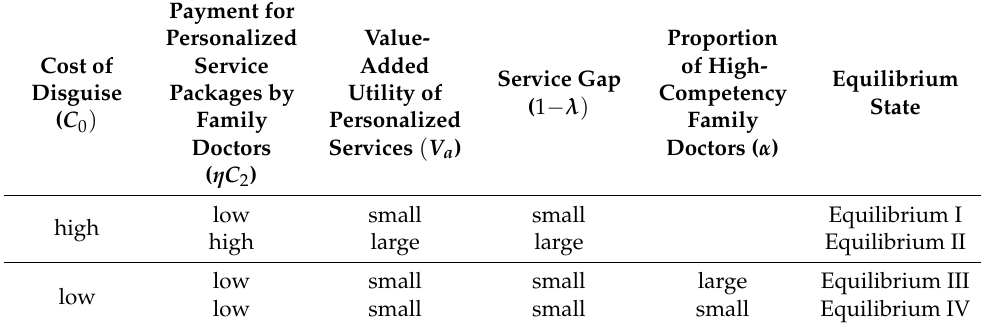
Table 1. Equilibrium states of the signaling